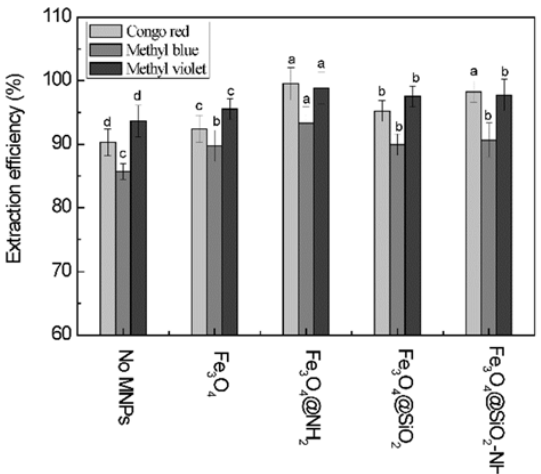
Figure 3. Effect of the MNPs added to the aqueous micellar two ‐ phase system (AMTPS) on the extraction efficiency of dyes. (Each system contained 10 mL dyes solution (1 mg/mL Congo red (CR), methyl blue (MB) and 0.125 mg/mL methyl violet (MV)).10 mg MNPs, 4 wt. % TX ‐ 114, 40 min vibration time, and incubated at temperature 40 °C for 10 min). Different letters in the same series indicate significant difference at p < 0.05 level.